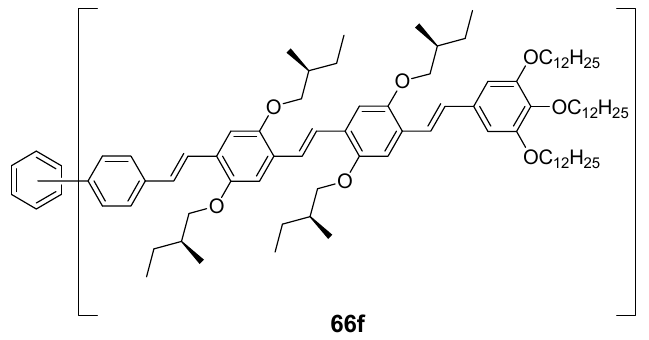
Figure 26. Disc-shaped mesogen self-assembling in helical